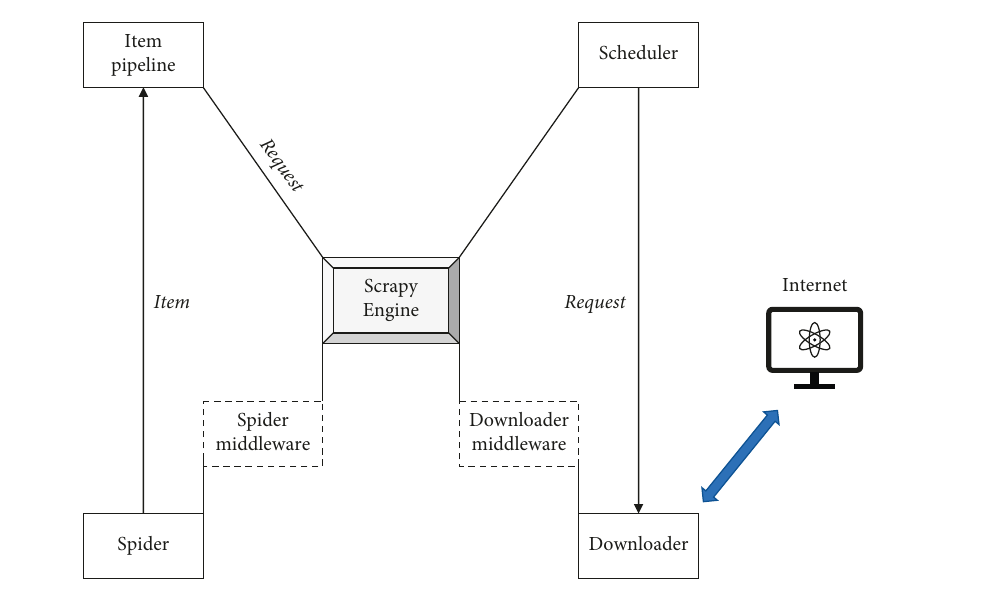
Figure 2: Basic architecture of Scrapy.